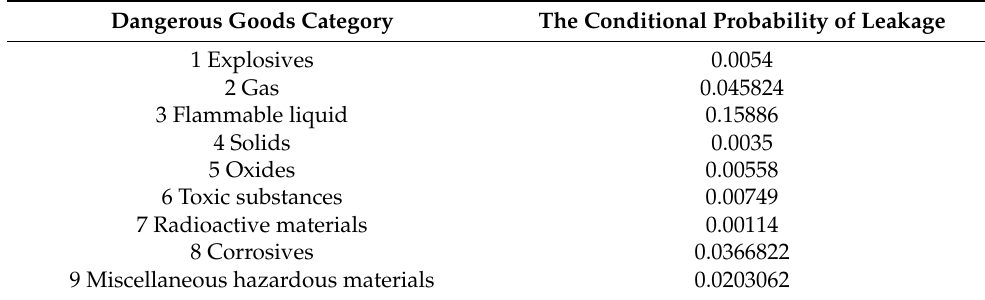
Table 13. Conditional probability of leakage of different dangerous goods